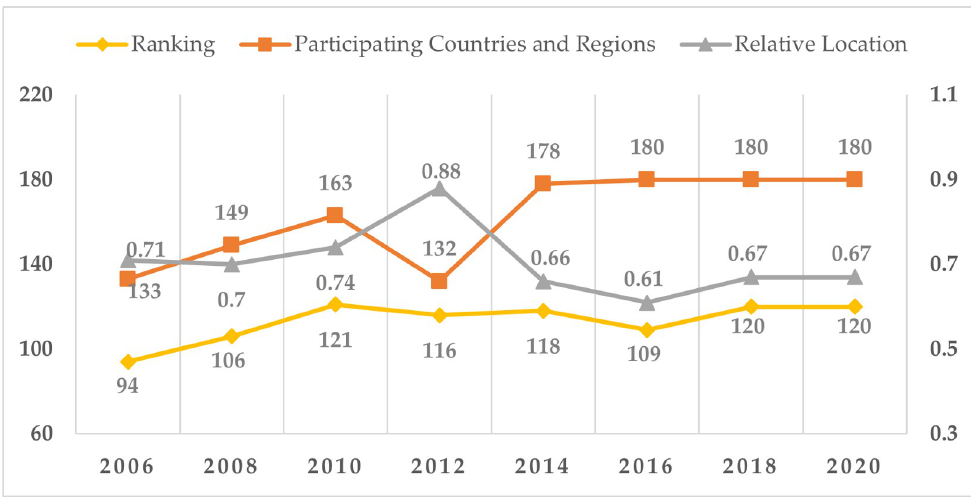
Fig 1. China’s EPI ranking